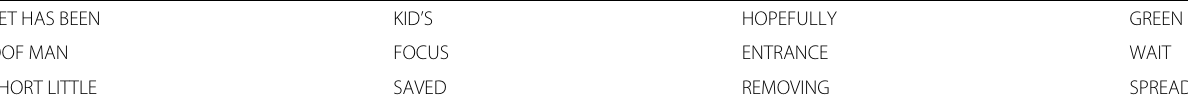
Table 2 Examples of OpenSAT20 keywords PET HAS BEEN KID’S HOPEFULLY GREEN OOF MAN FOCUS ENTRANCE WAIT SHORT LITTLE SAVED REMOVING SPREAD